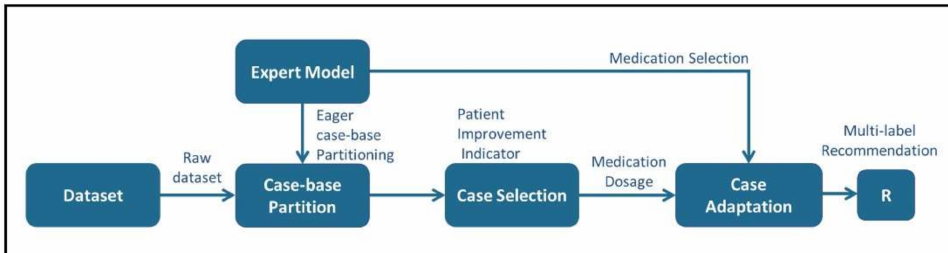
Figure 2. Abstract diagram depicting the role of domain knowledge and clinical cases in the proposed